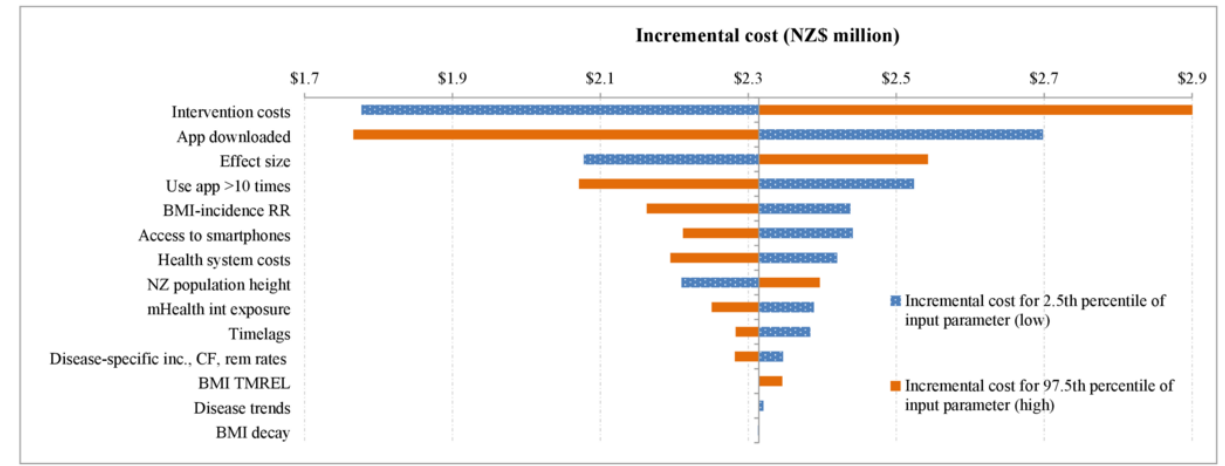
Figure 3. Tornado plot indicating which parameters drive uncertainty in the model results for health system costs for the population. BMI: body mass index; CF: case fatality; inc: incidence; mHealth: mobile health; NZ: New Zealand; rem: remission; RR: relative risks; TMREL: theoretical minimum risk exposure